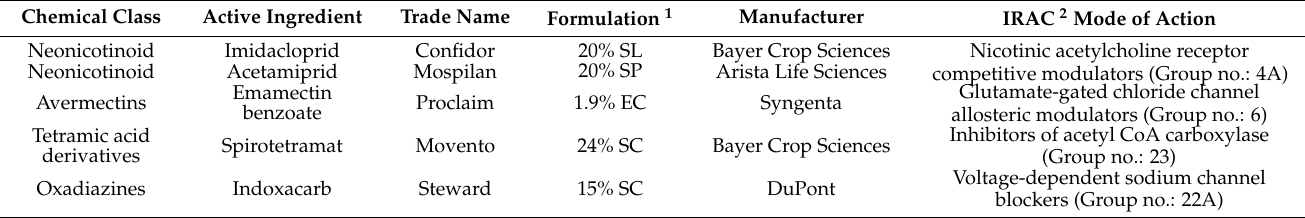
Table 1. List of the insecticides used in the Culex quinquefasciatus